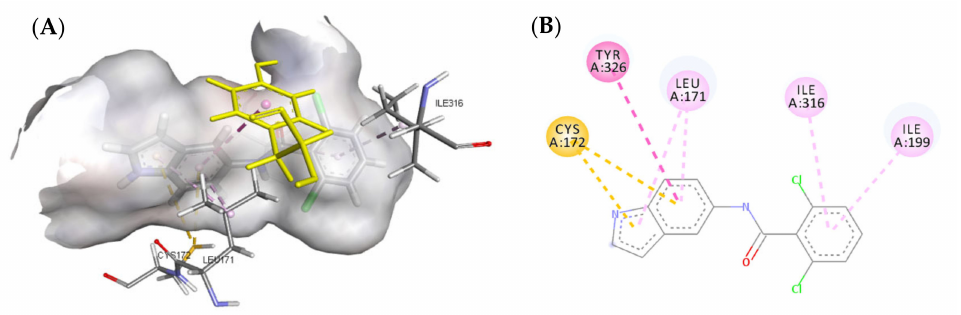
Figure 6. ( A ) Three-dimensional (3D) representation of the interactions of compound 3x with MAO-B; ( B ) Two-dimensional (2D) interaction model compound 3x with